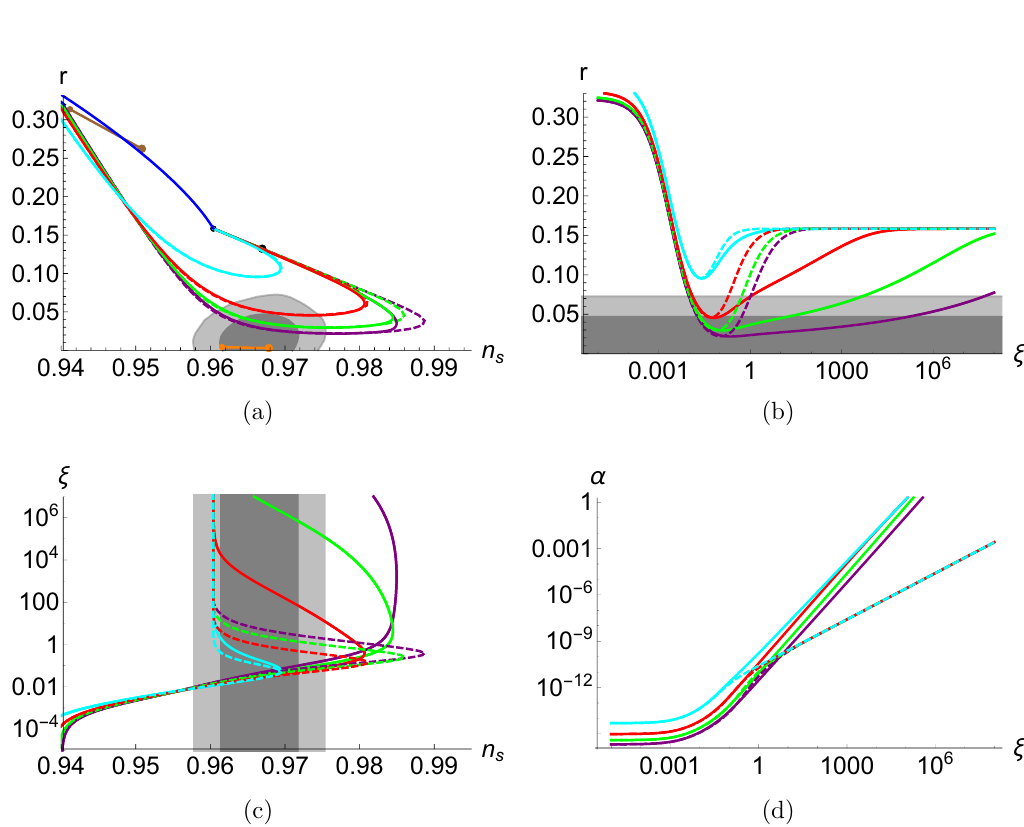
Figure 11. r vs. n s (a), r vs. ξ (b), ξ vs. n s (c) and α vs. ξ (d) for δ = 10 − 6 , 10 − 4 , 10 − 2 , 1 respectively in purple, green, red and cyan with N e = 50 e -folds in region 3. Continuous/dashed line represents metric/Palatini gravity. For reference we plot the predictions of CW inflation for N e = 50 (blue), R 2 (orange), χ 2 (black) and χ 4 (brown) inflation for N e ∈ [50 , 60] . The gray areas represent the 1,2 σ allowed regions from Planck 2018 data [6].